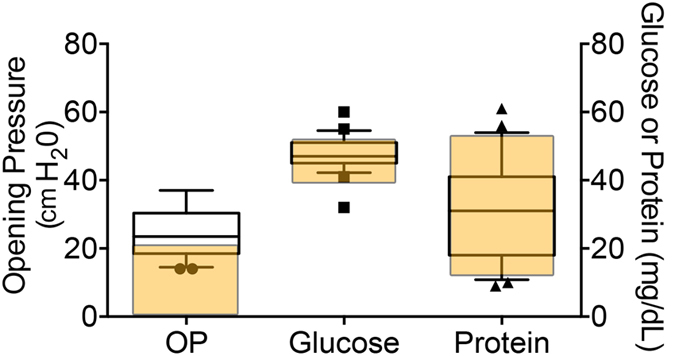
CSF opening pressure (OP), glucose, and total protein in MPS-IH patients.The boxes represent to 25th to 75th percentiles with a line at the mean. Whiskers show the 10th and 90th percentiles. Symbols represent value outside the 10 – 90th percentile. The yellow area indicates the normal range for age at our institution.